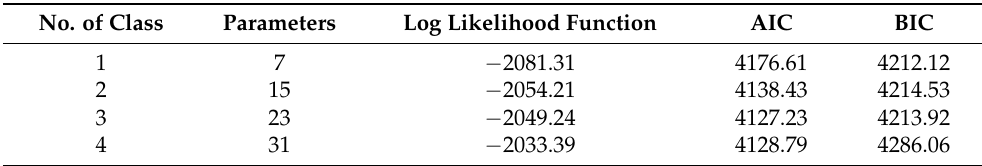
Table 6. Statistics for latent-class regression models ( comfortable sense ).